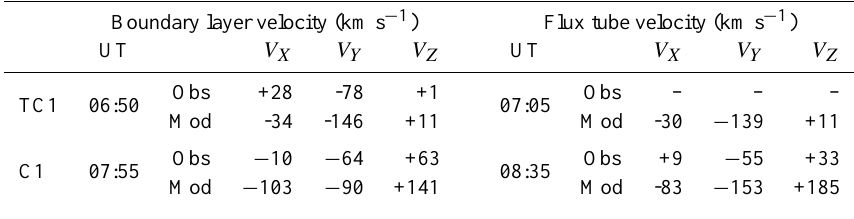
Table 1. A summary of the measured and modelled boundary layer and flux tube velocities presented in Fig. 12.